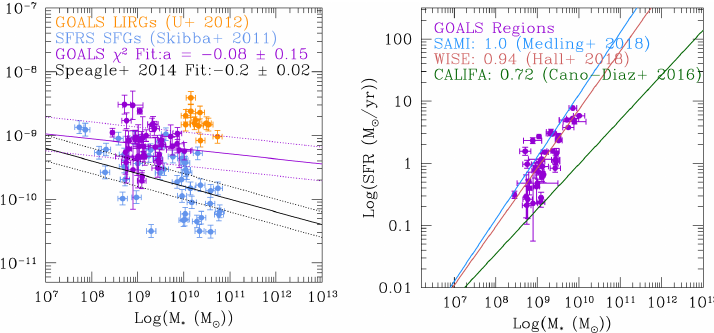
Figure 1. ( Left ) The specific SFR (=SFR/M ∗ ) distribution as a function of the stellar mass shows that the galaxy-integrated (orange) and extranuclear star-forming regions (purple) in GOALS LIRGs are above local star-forming galaxies (blue; [37]) or the global fit from Speagle et al. [35]. ( Right ) The SFMS for the GOALS star-forming regions plotted against the normalized resolved galaxy main sequence from other surveys [38–40]. Figure from Linden et al. [36]; © AAS, reproduced with